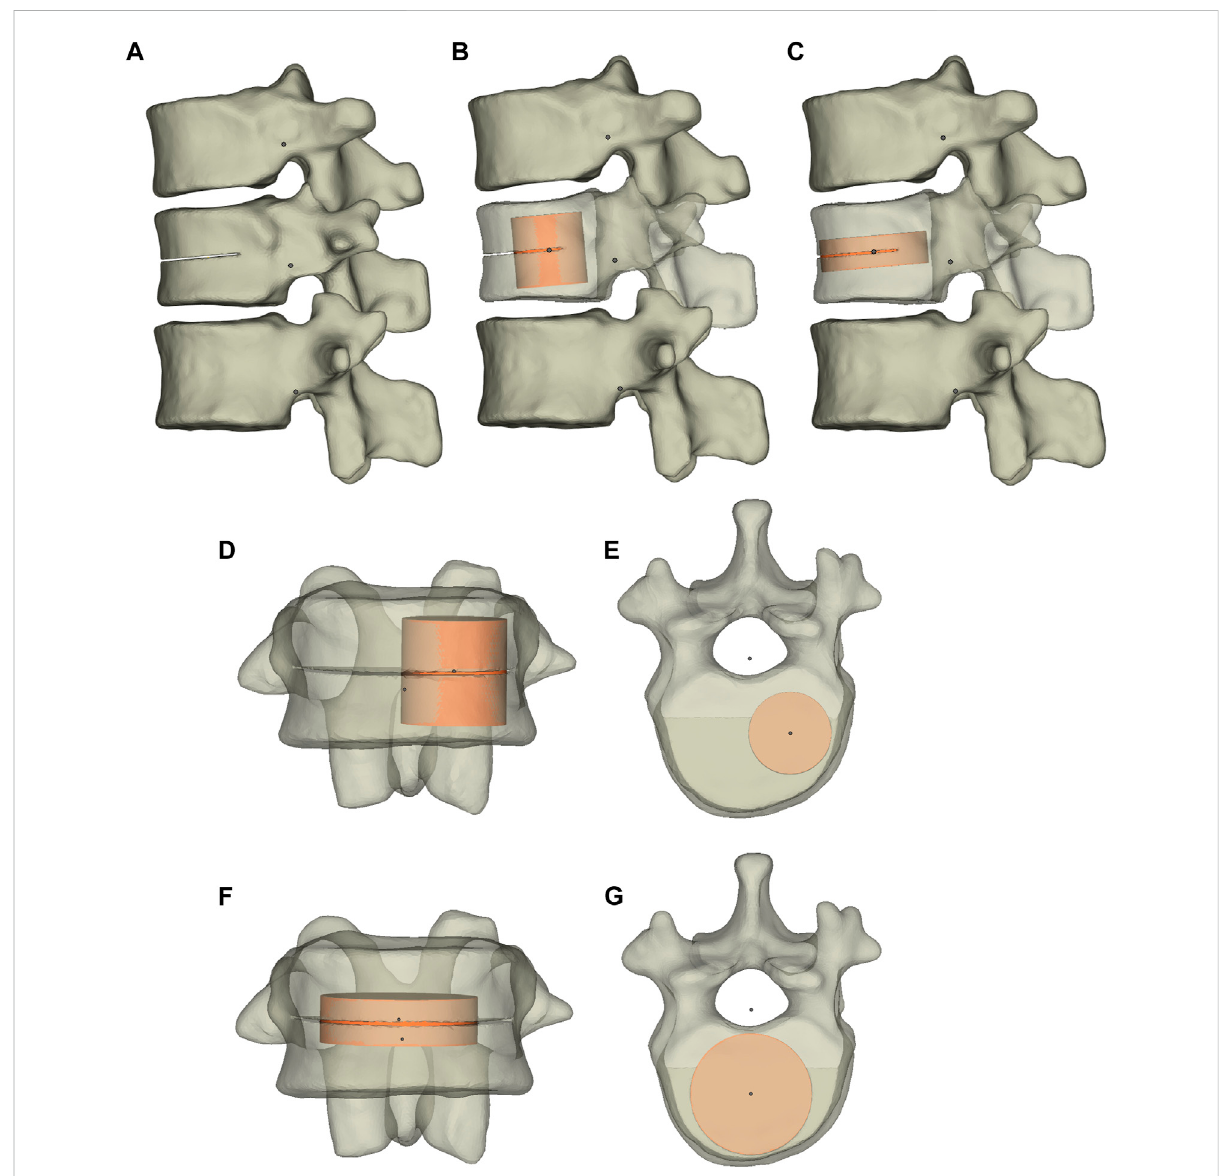
FIGURE 2 The T11-L1 three-dimensional model and T12 fracture model. The T11-L1 three-dimensional model (A) and the T12 vertebral body after UPVP (B) and BPVP (C) . (D) Frontal view of the T12 vertebral body after UPVP. (E) Superior view of the T12 vertebral body after UPVP. (F) Frontal view of the T12 vertebral body after BPVP. (G) Superior view of the T12 vertebral body after